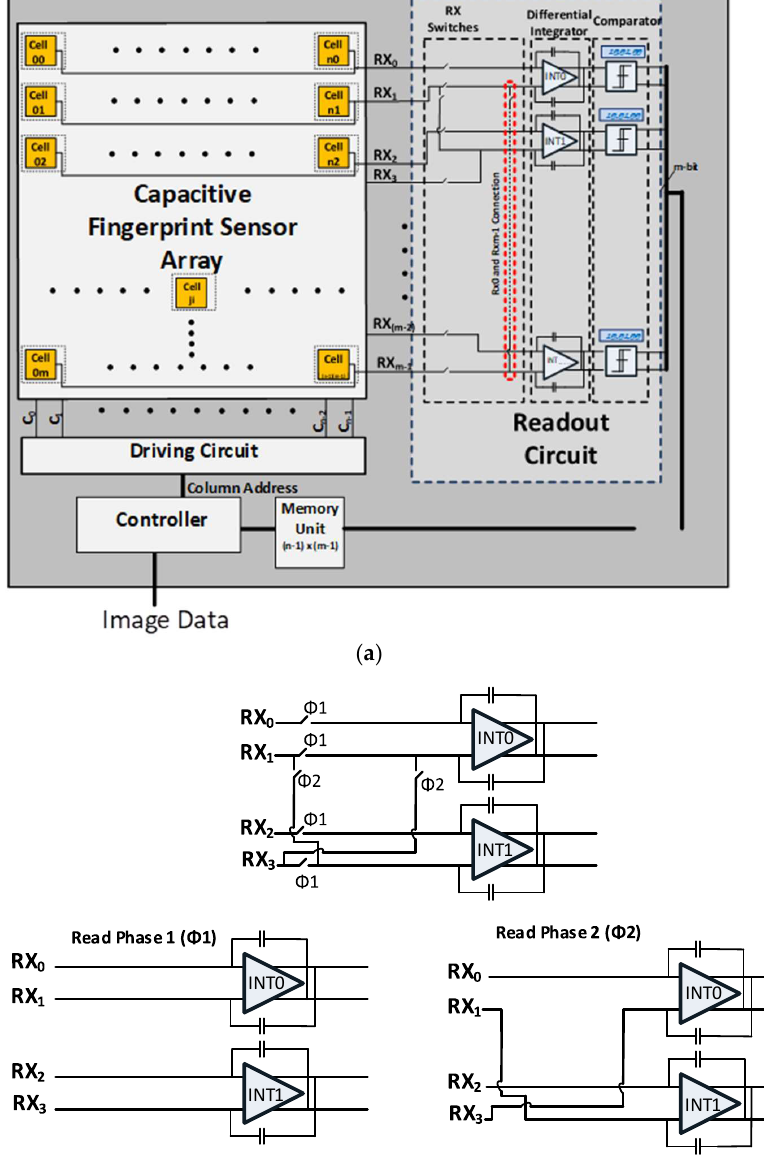
Figure 3. The proposed capacitive fingerprint differential sensing scheme. ( a ) Block diagram; ( b ) simplified switching mechanism between read phase 1 and read phase 2.